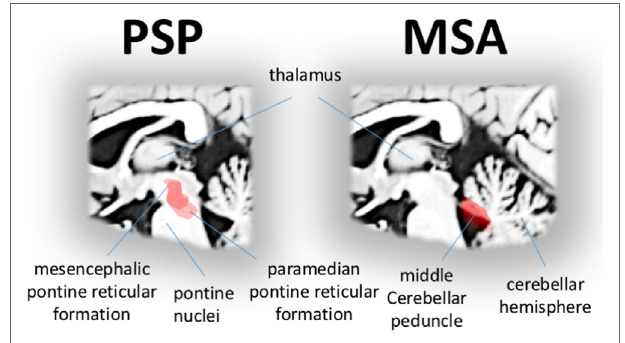
FiGURe 4 | Disease-specific correlations of eye movement alterations in progressive supranuclear palsy (PSP) and multisystem atrophy (MSA). Specific correlations (red area) between microstructural impairment and gaze palsy in patients with PSP showing midbrain and brainstem regions typically associated with eye velocity (left). Specific correlations (red area) between microstructural impairment in ponto-cerebellar structures and the shape of saccadized smooth pursuit in patients with MSA